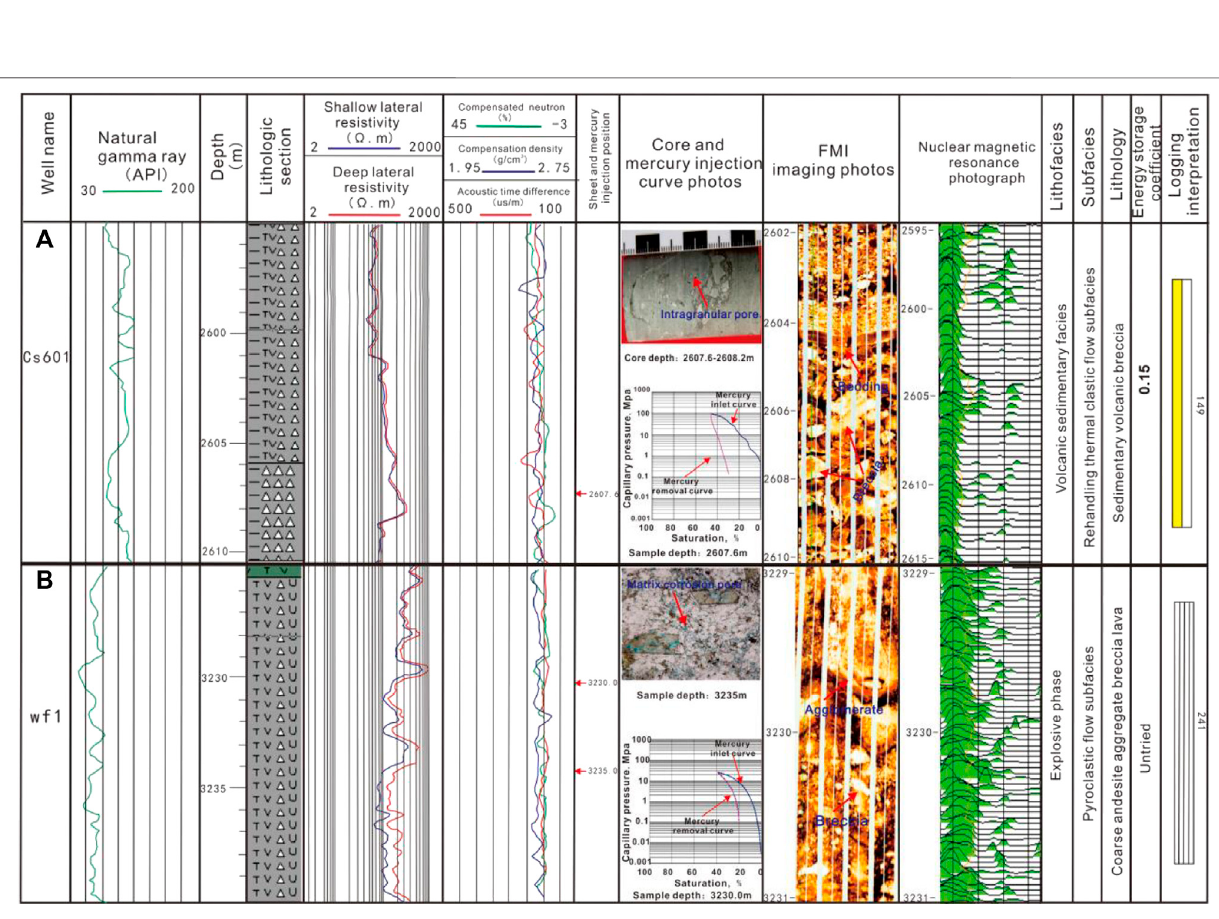
Frontiers in Earth Science |